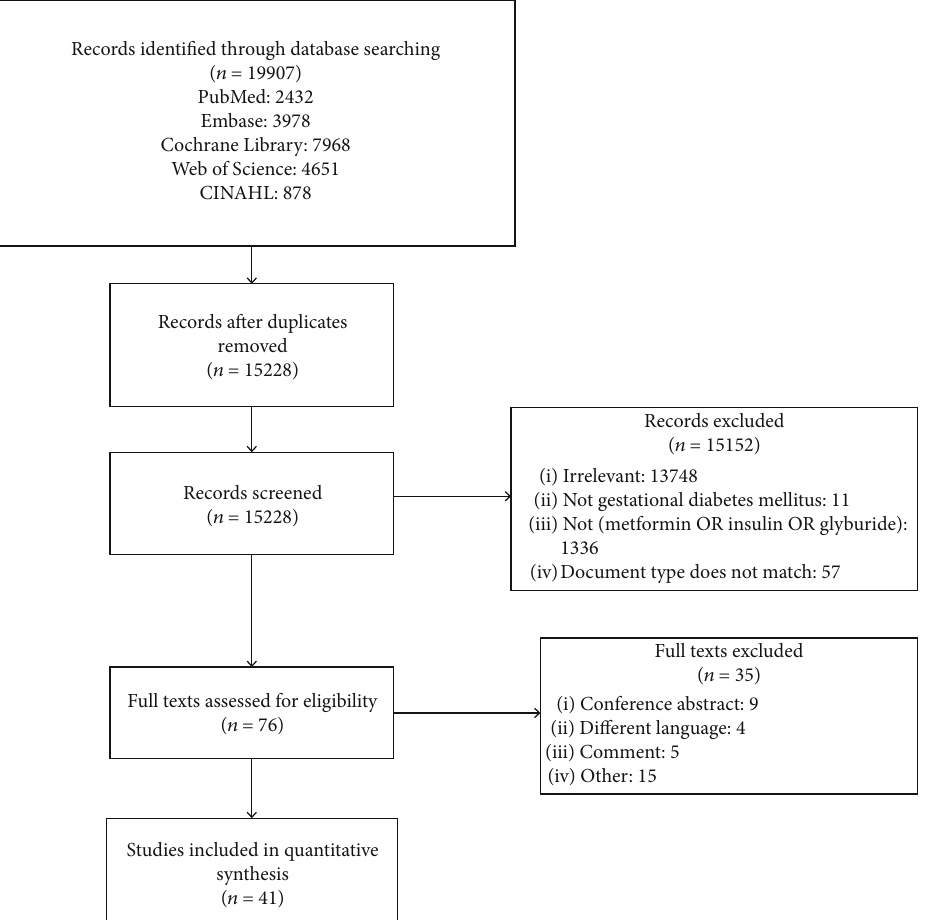
Figure 1: The search fl ow